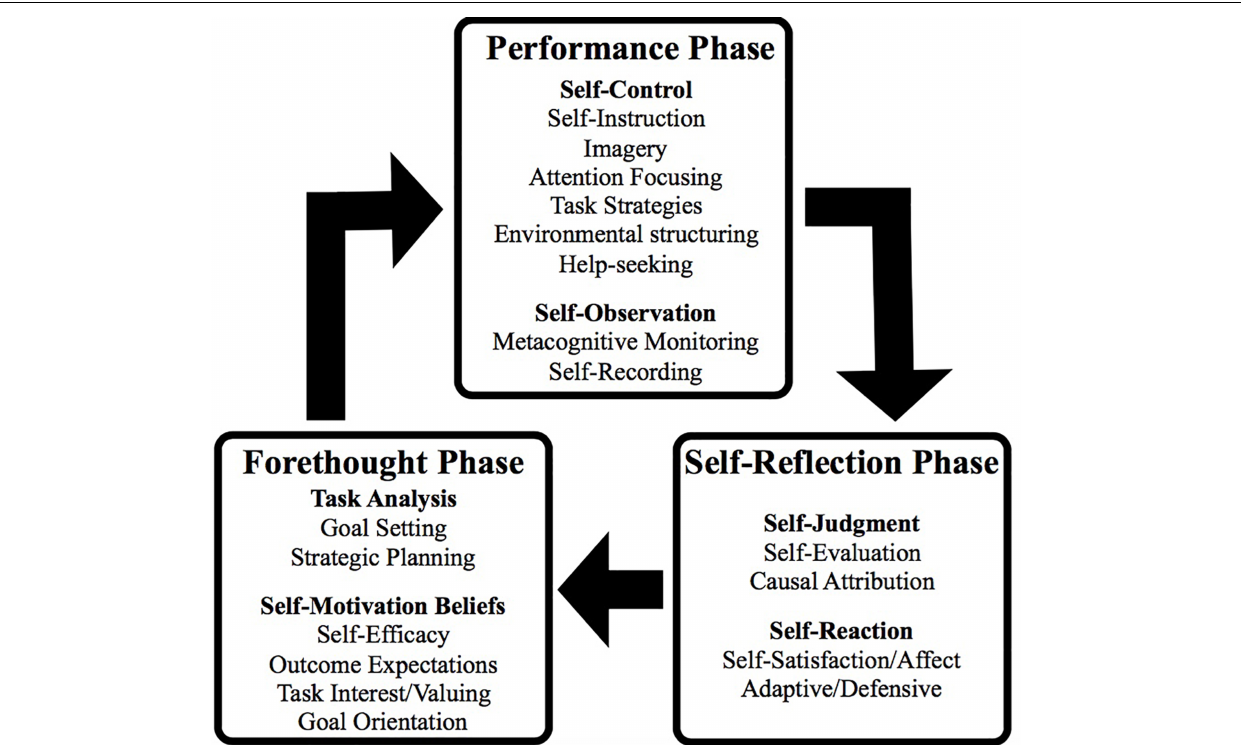
FIGURE 1 | Phases and sub-processes of self-regulated learning (from Zimmerman and Campillo, 2003, p.